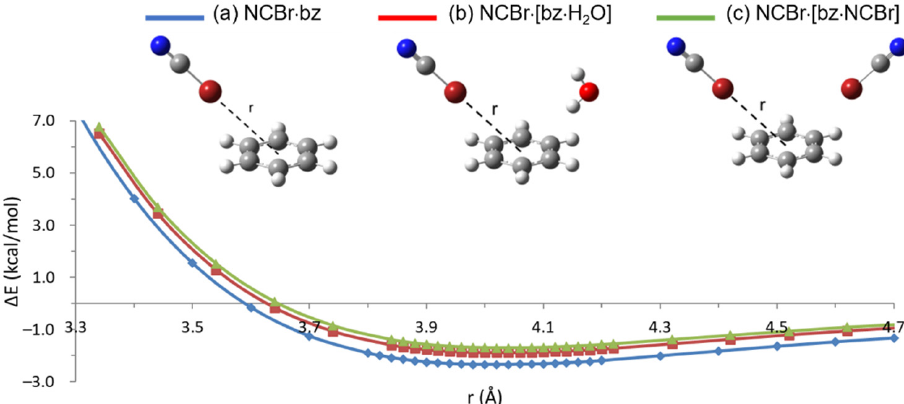
Figure 3. Binding energy curves, ∆ E, vs. Br distance from the center of benzene ring, r, computed for ( a ) NCBr · bz (blue line), ( b ) NCBr · [bz · H 2 O] (red line), and ( c ) NCBr · [bz · NCBr] (green line) sys- tems in the perpendicular approach at the M06-2X/aug-cc-PVTZ level of theory.